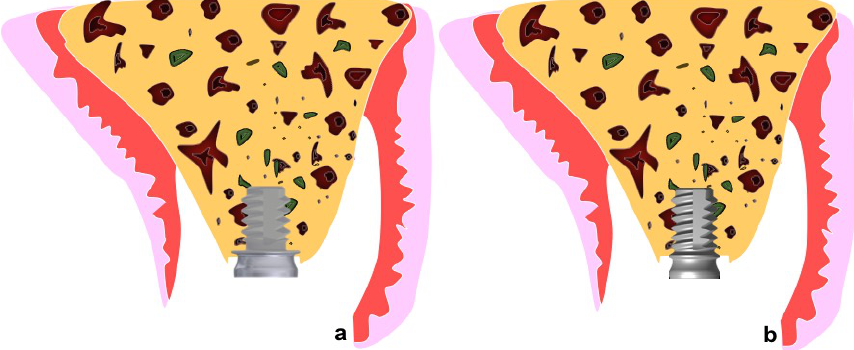
Figure 2. ( a ) Wide ring extra-short implant after flap elevation; ( b ) narrow ring extra-short implants installed in the maxilla.